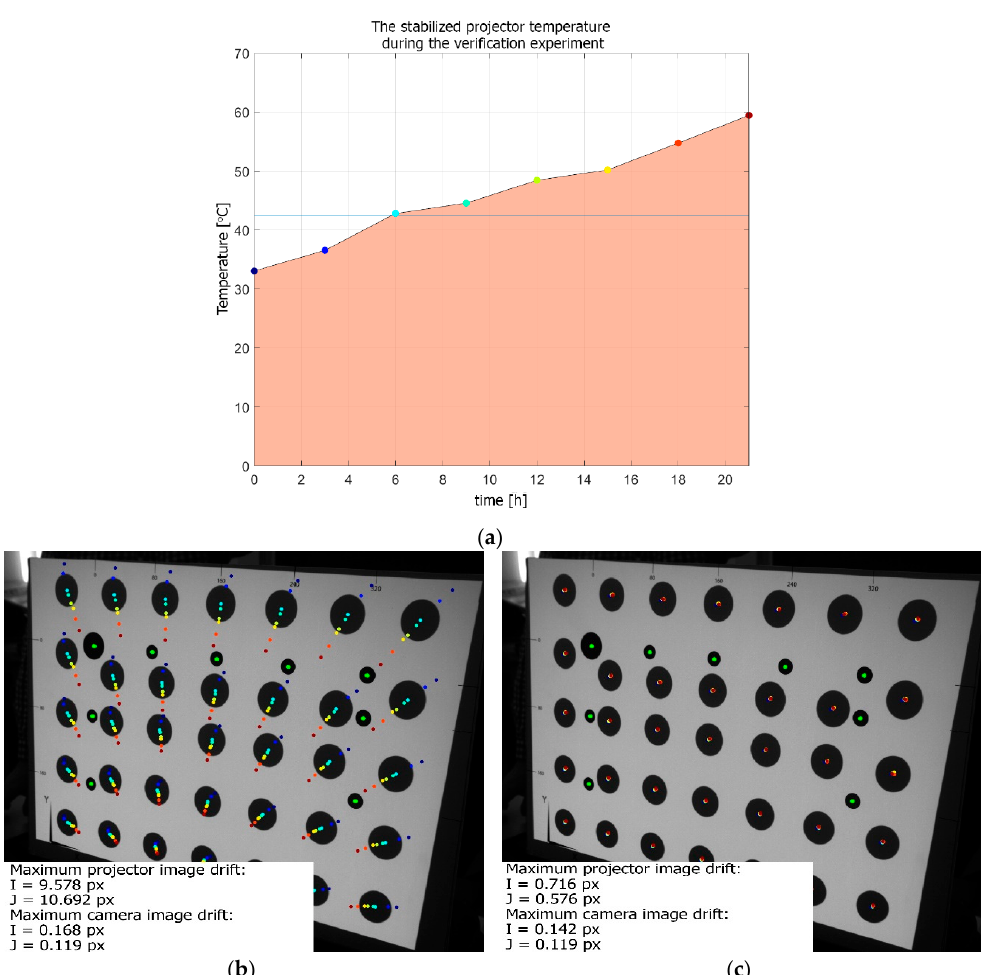
Figure 14. Results of the verification experiment: ( a ) the stabilized projector temperatures; ( b ) the trajectories of the markers calculated for the projection of the undeformed (original) bitmap; and ( c ) the marker trajectories calculated for the projection of the bitmaps deformed using the calculated compensation